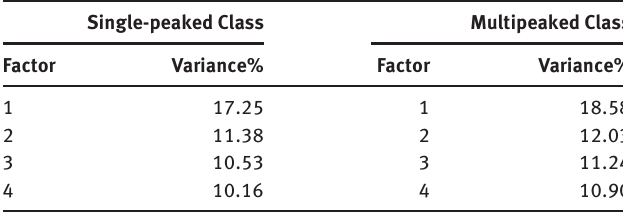
Table 3. Variances of